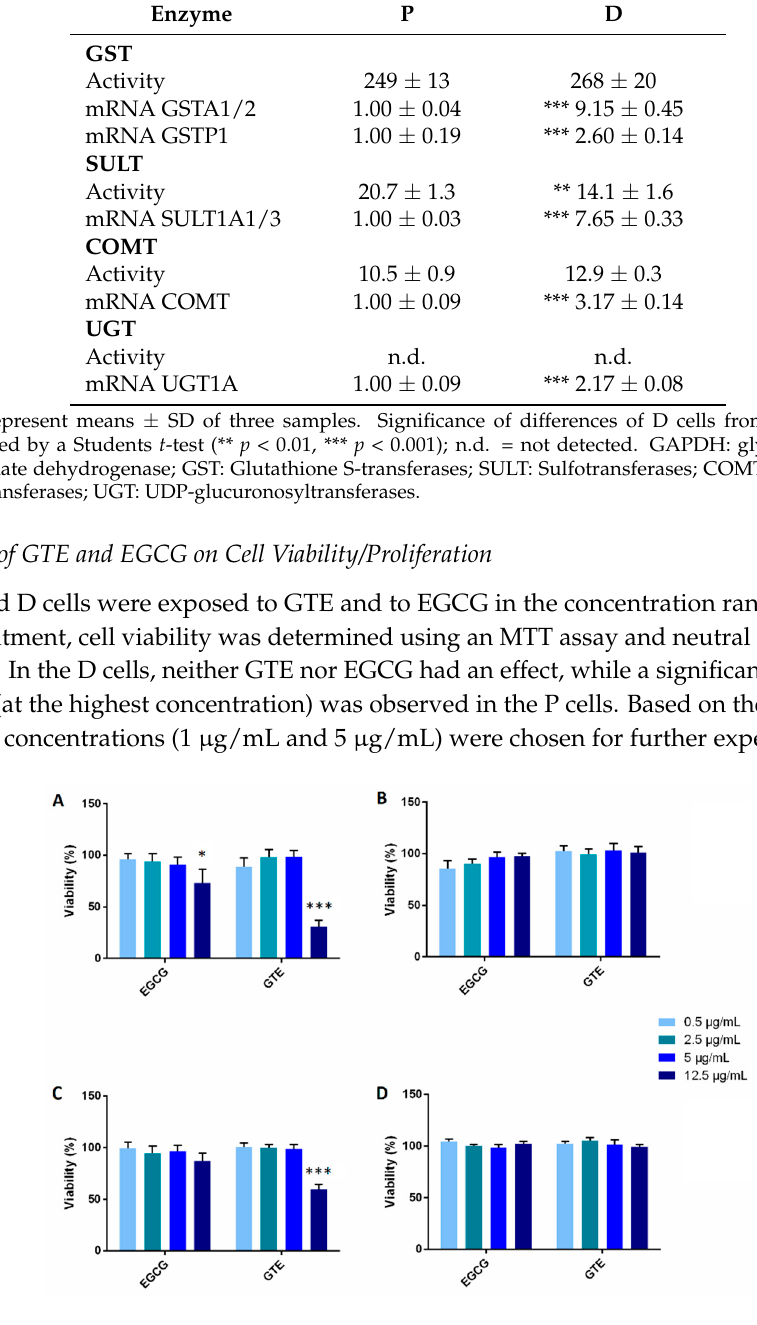
Figure 1. Viability of cells after exposure to epigallocatechin gallate (EGCG) and green tea extract (GTE) in four concentrations. MTT assay ( A , B ) and neutral red uptake (NRU) test ( C , D ) of proliferating ( A , C ) and differentiated ( B , D ) Caco-2 cells. The viabilities of treated cells are expressed as the percentage of untreated controls (100%). Values represent means ± SD of three samples. Significance of differences from the control was determined by ANOVA followed by a Dunnett’s test (* p < 0.05, *** p < 0.001).